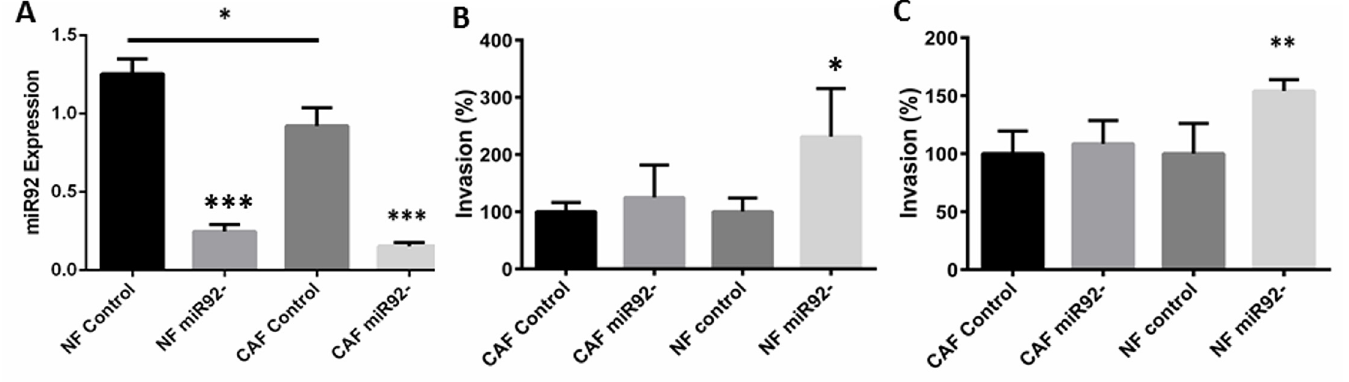
Fig 5. Down-regulation of miR92 expression in normal fibroblasts (NFs), but not cancer associated fibroblasts (CAFs), significantly enhances the invasive capacity of breast cancer epithelial cells. Matched NFs and CAFs were reverse transfected with either an inhibitor of miR92 or negative control (A) and a Matrigel ™ invasion assay was used to assess effects on the behaviour of breast cancer epithelial cells 48 hours post- transfection. Down-regulation of miR92 significantly increased the invasion of MCF7 (B) and MDA-MB – 231 (C) cells. Error bars are ± S.D. * denotes significance of p < 0.05; ** denotes significance of p < 0.01; *** denotes significance of p < 0.001.